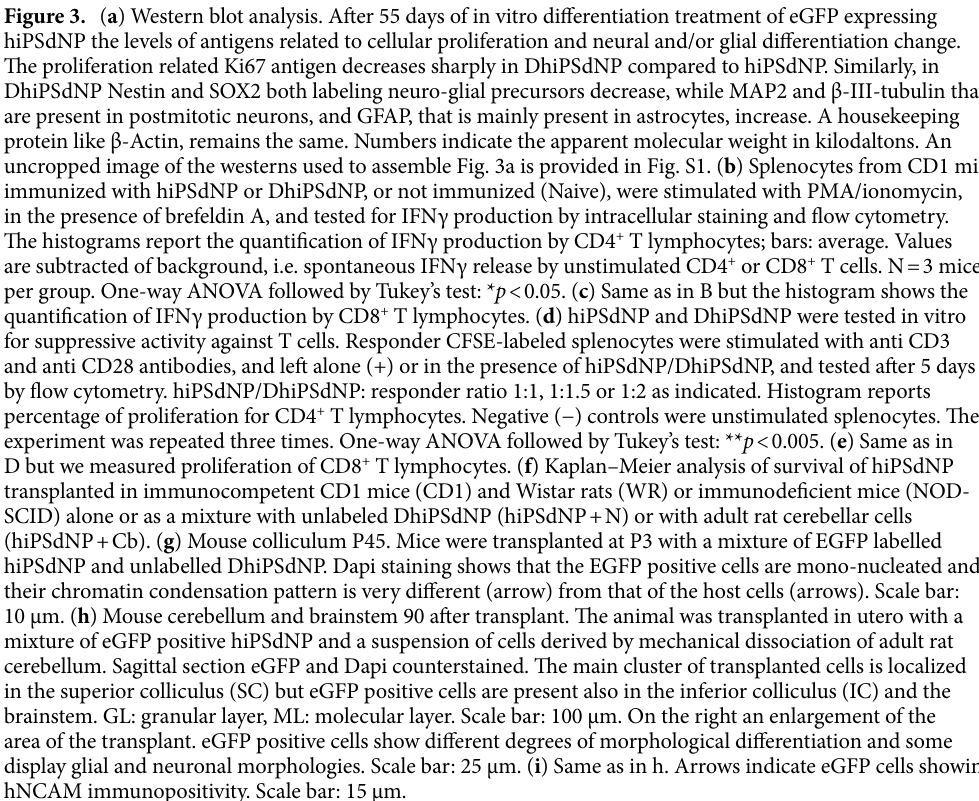
Figure 3. ( a ) Western blot analysis. After 55 days of in vitro differentiation treatment of eGFP expressing hiPSdNP the levels of antigens related to cellular proliferation and neural and/or glial differentiation change. The proliferation related Ki67 antigen decreases sharply in DhiPSdNP compared to hiPSdNP. Similarly, in DhiPSdNP Nestin and SOX2 both labeling neuro-glial precursors decrease, while MAP2 and β-III-tubulin that are present in postmitotic neurons, and GFAP, that is mainly present in astrocytes, increase. A housekeeping protein like β-Actin, remains the same. Numbers indicate the apparent molecular weight in kilodaltons. An uncropped image of the westerns used to assemble Fig. 3a is provided in Fig. S1. ( b ) Splenocytes from CD1 mice immunized with hiPSdNP or DhiPSdNP, or not immunized (Naive), were stimulated with PMA/ionomycin, in the presence of brefeldin A, and tested for IFNγ production by intracellular staining and flow cytometry. The histograms report the quantification of IFNγ production by CD4 + T lymphocytes; bars: average. Values are subtracted of background, i.e. spontaneous IFNγ release by unstimulated CD4 + or CD8 + T cells. N = 3 mice per group. One-way ANOVA followed by Tukey’s test: * p < 0.05. ( c ) Same as in B but the histogram shows the quantification of IFNγ production by CD8 + T lymphocytes. ( d ) hiPSdNP and DhiPSdNP were tested in vitro for suppressive activity against T cells. Responder CFSE-labeled splenocytes were stimulated with anti CD3 and anti CD28 antibodies, and left alone (+) or in the presence of hiPSdNP/DhiPSdNP, and tested after 5 days by flow cytometry. hiPSdNP/DhiPSdNP: responder ratio 1:1, 1:1.5 or 1:2 as indicated. Histogram reports percentage of proliferation for CD4 + T lymphocytes. Negative (−) controls were unstimulated splenocytes. The experiment was repeated three times. One-way ANOVA followed by Tukey’s test: ** p < 0.005. ( e ) Same as in D but we measured proliferation of CD8 + T lymphocytes. ( f ) Kaplan–Meier analysis of survival of hiPSdNP transplanted in immunocompetent CD1 mice (CD1) and Wistar rats (WR) or immunodeficient mice (NOD- SCID) alone or as a mixture with unlabeled DhiPSdNP (hiPSdNP + N) or with adult rat cerebellar cells (hiPSdNP + Cb). ( g ) Mouse colliculum P45. Mice were transplanted at P3 with a mixture of EGFP labelled hiPSdNP and unlabelled DhiPSdNP. Dapi staining shows that the EGFP positive cells are mono-nucleated and their chromatin condensation pattern is very different (arrow) from that of the host cells (arrows). Scale bar: 10 µm. ( h ) Mouse cerebellum and brainstem 90 after transplant. The animal was transplanted in utero with a mixture of eGFP positive hiPSdNP and a suspension of cells derived by mechanical dissociation of adult rat cerebellum. Sagittal section eGFP and Dapi counterstained. The main cluster of transplanted cells is localized in the superior colliculus (SC) but eGFP positive cells are present also in the inferior colliculus (IC) and the brainstem. GL: granular layer, ML: molecular layer. Scale bar: 100 µm. On the right an enlargement of the area of the transplant. eGFP positive cells show different degrees of morphological differentiation and some display glial and neuronal morphologies. Scale bar: 25 µm. ( i ) Same as in h. Arrows indicate eGFP cells showing hNCAM immunopositivity. Scale bar: 15